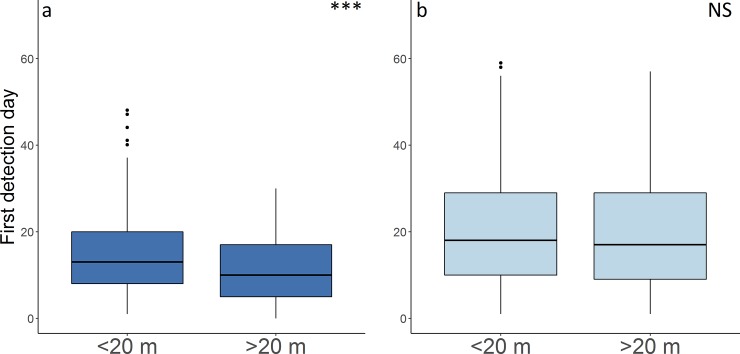
Boxplot of first detection day to the object of (a) tuna and (b) non-tuna species for the different depth category of DFADs. Asterisks indicate the significance levels of differences following Mann-Whitney U test (* p < 0.05; ** p < 0.01; *** p < 0.001; NS not significant).